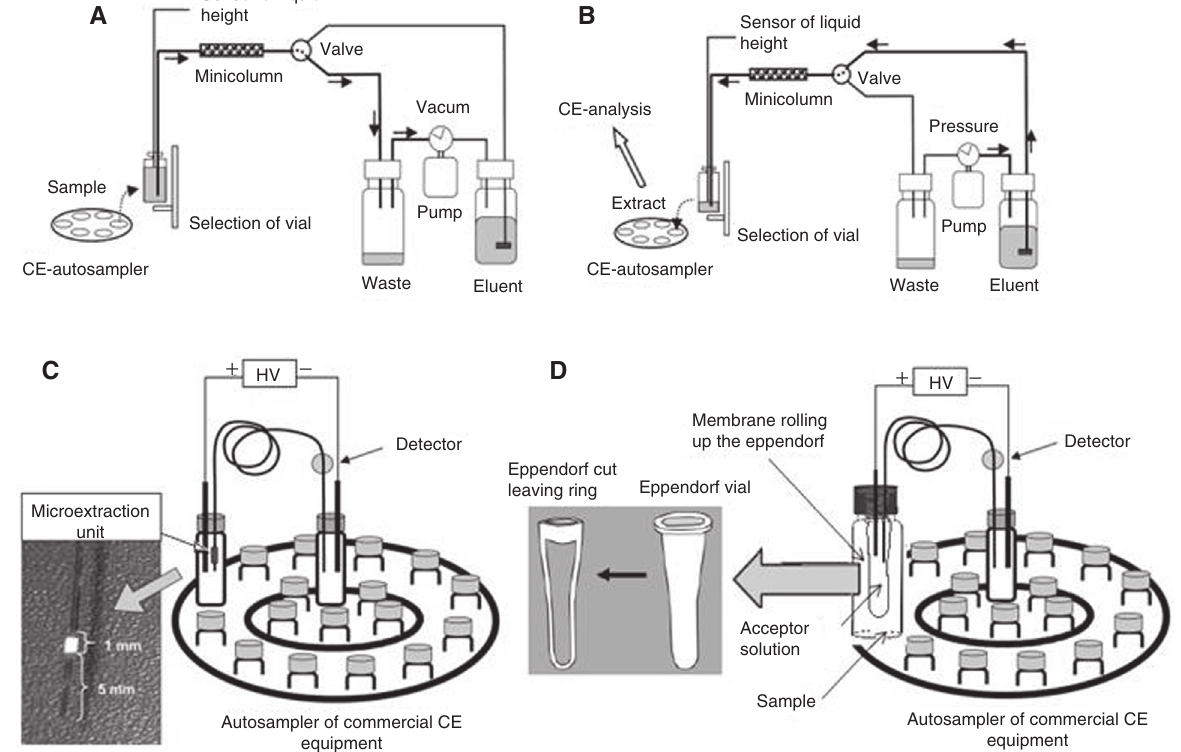
Figure 3 Schematic description of in-line coupling sample treatment unit to commercial CE equipment using a (A and B) replenishment system, (C) microextraction unit in-capillary (D) microextraction unit in-vial. Reproduced with permission from John Wiley & Sons [Santos et al. 2004a,b, Nozal et al. 2006,